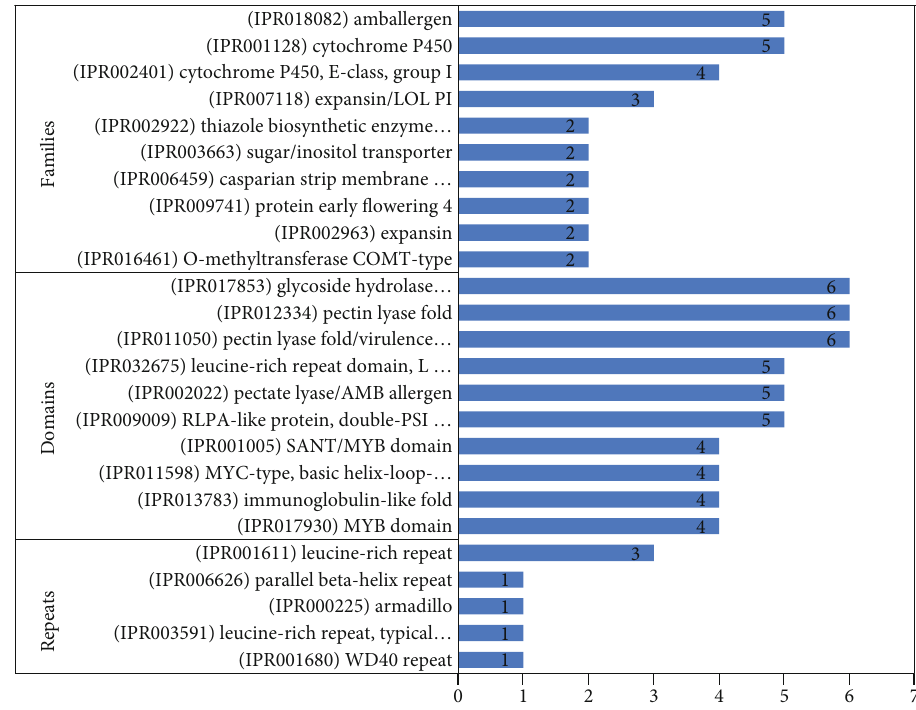
Figure 6: Top 10 downregulated families, domains, repeats, and sites under drought